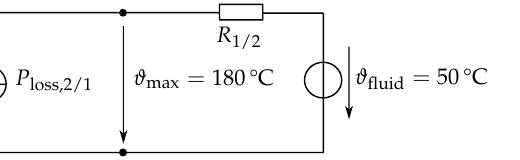
Figure 10. LPTN model of the simplified case study for the stator and the rotor.